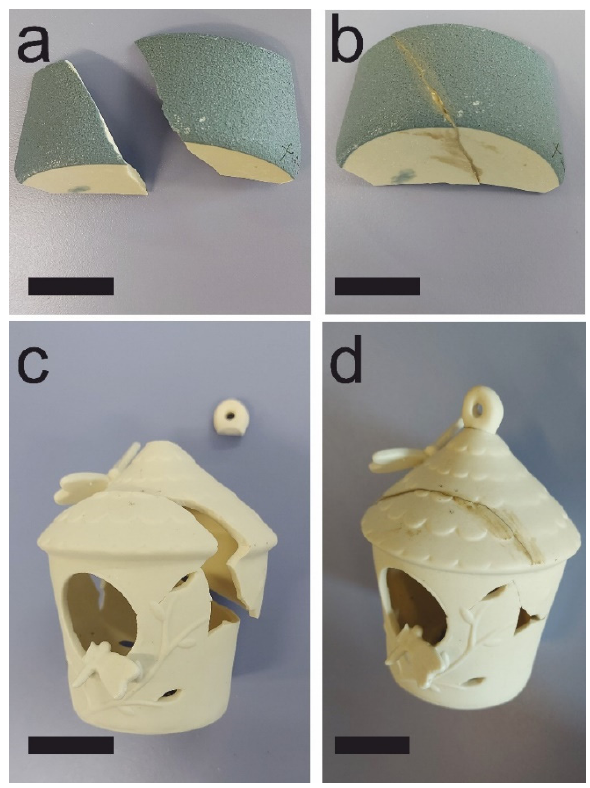
Figure 8. Porcelain stoneware and pottery artworks ( a – c ) were restored (respectively in ( b – d ) picture) and repaired by using the geopolymer-based material MK-PVAc-10 prepared in this work (black scale bar indicates 5 cm).